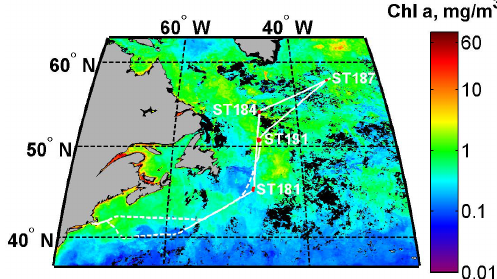
Fig. 1. Cruise track from the Knorr_11 study, with the location of stations marked in red. The cruise track is superimposed on a satel- lite map of chlorophyll a from